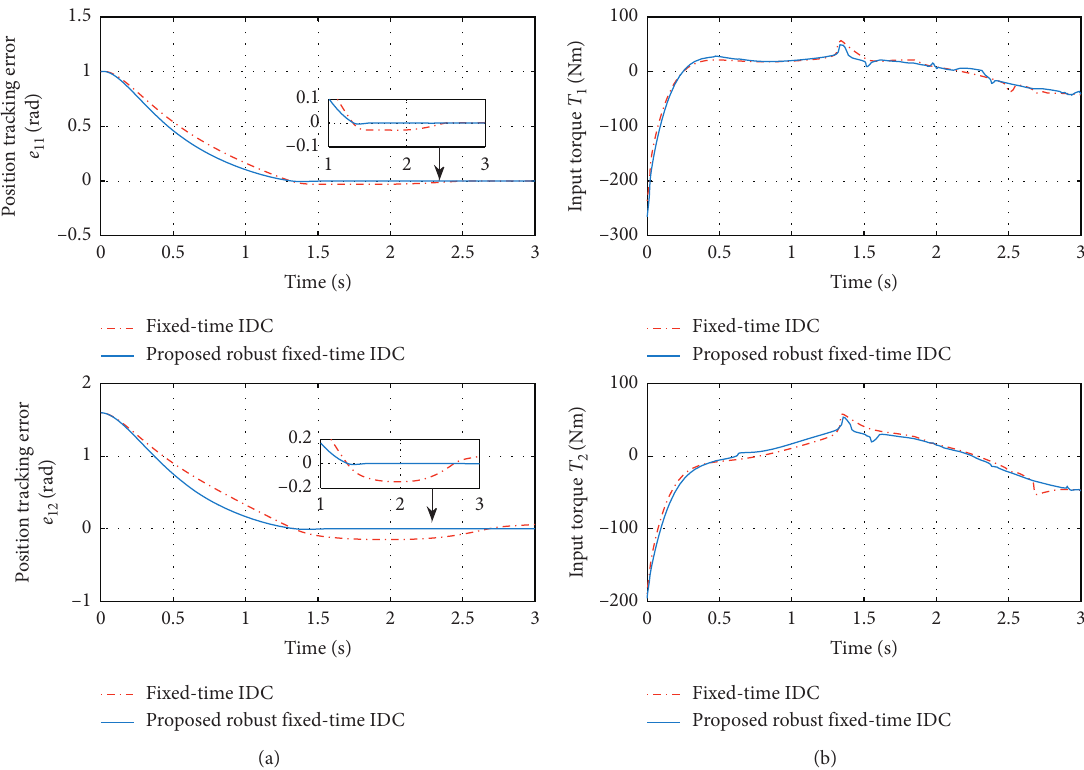
Figure 5: Responses in case 4. (a) Position tracking errors. (b) Input torques.